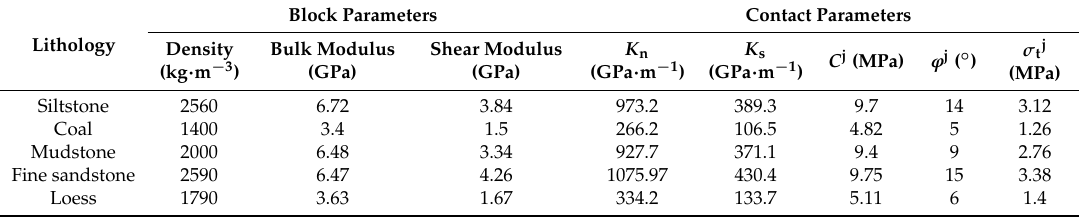
Table 3. Calibrated Young’s modulus value and the compressive strength value in the UDEC